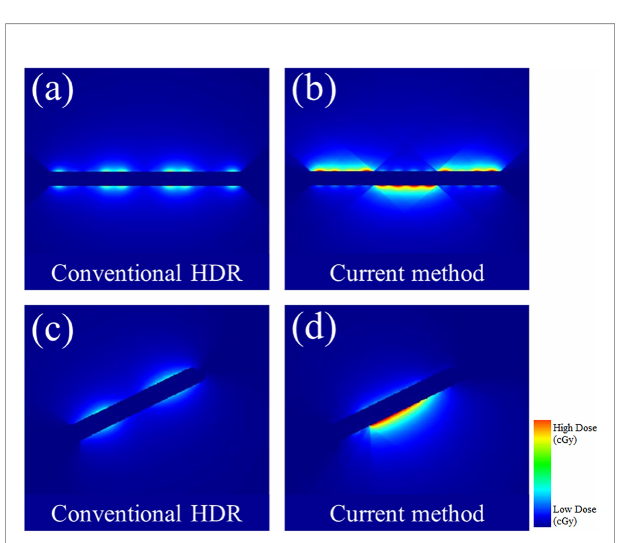
FIGURE 7 | A comparison between the conventional HDR method and our proposed (current method) with the 3D metal printing for anisotropic fi eld. (A, B) : The dose distribution estimated using the 2D phantom data. (C, D) : The dose distribution estimated using the 2D patient data.